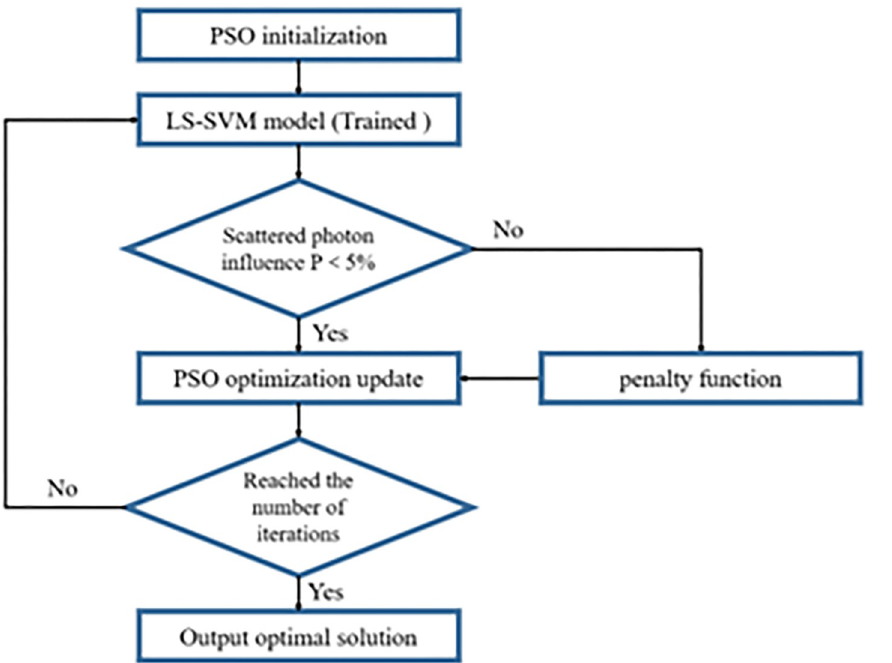
Fig 3. Optimized design process of minitype reference radiation.